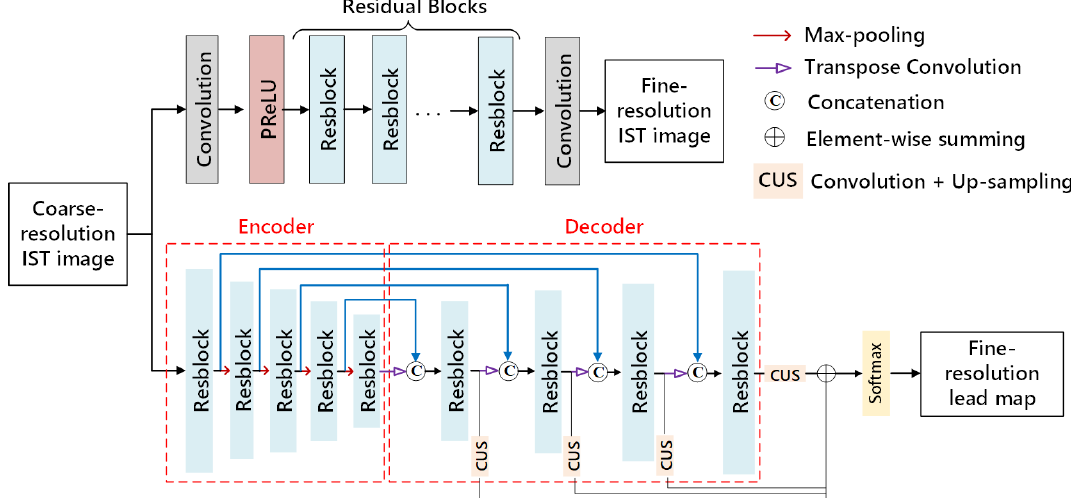
Figure 5. Architecture of the two CNNs used for the IST image super-resolution reconstruction and super-resolution lead mapping. Note that PReLU stands for parametric rectified linear